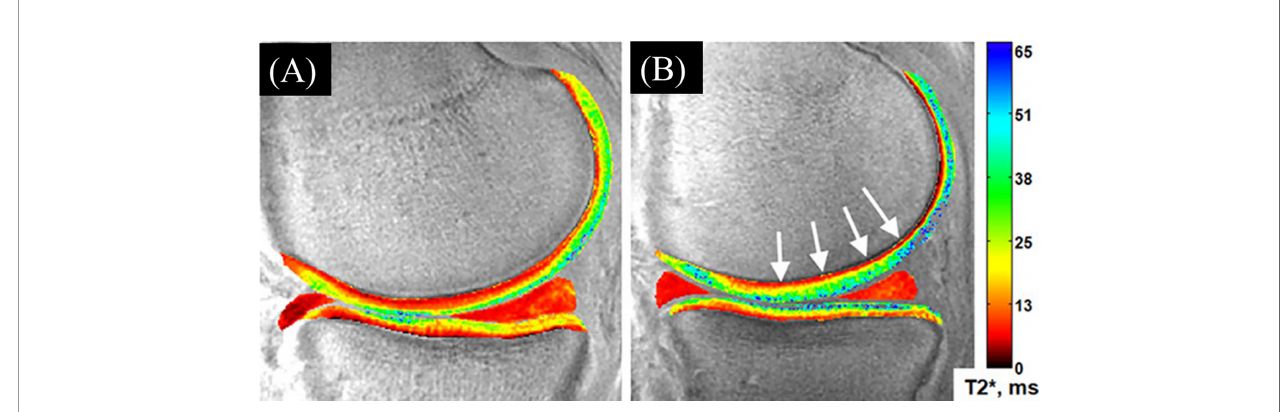
FIGURE 5 | A sample of 2D UTE-T ∗ 2 maps. (A) An uninjured 29-year-old male control subject with typical laminar appearance to UTE-T ∗ 2 values. (B) 34-year-old male ACL reconstruction subject 2 years following surgery, without morphological evidence of medial cartilage (Outerbridge grade 0) pathology, demonstrates elevations to UTE-T ∗ 2 values throughout the medial femoro-tibial cartilage region, speci fi cally in deep medial femoral cartilage (white arrows). Modi fi ed, with permission from Ref